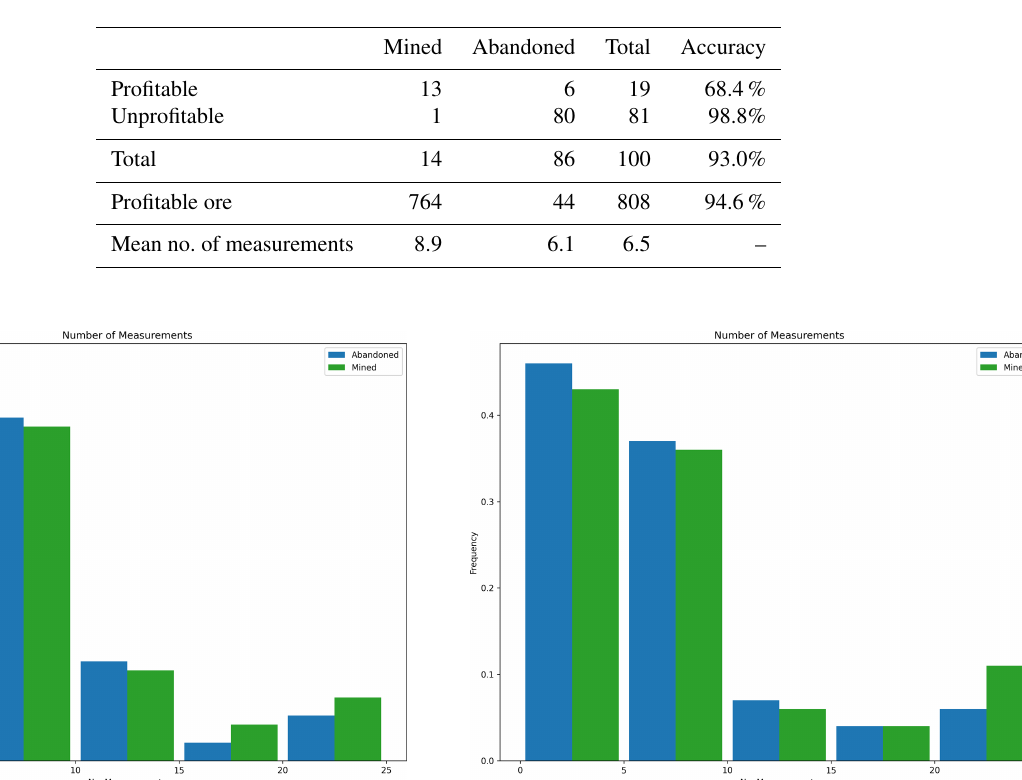
Table 7. Multi-body POMCPOW results with action constraints.